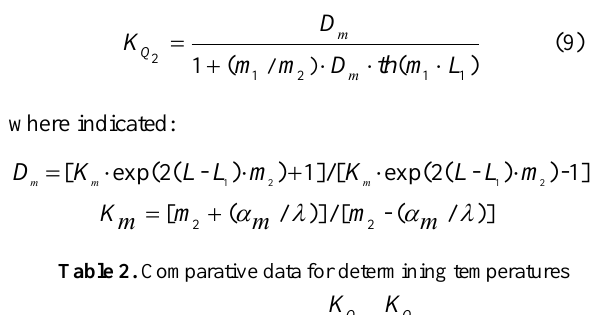
Table 2. Comparative data for determining temperatures by (8) for different 1 Q